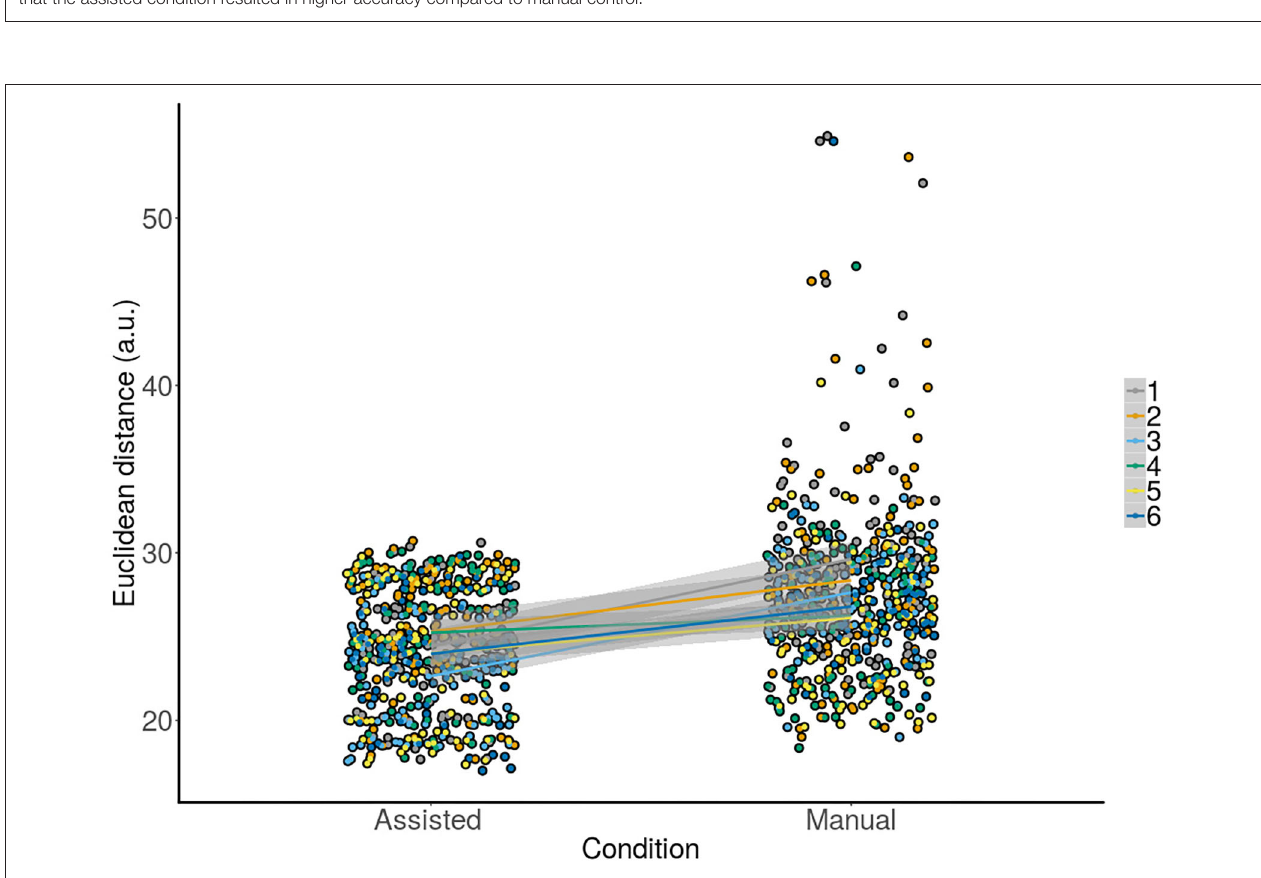
FIGURE 4 | Raw data with corresponding overlaid regression lines and shaded SEs for the assisted vs. manual condition across all subjects. The y-axis shows accuracy for all trials for each subject individually. A positive slope from the assisted to the manual condition means that our controller improved accuracy across trials. This can be observed for all